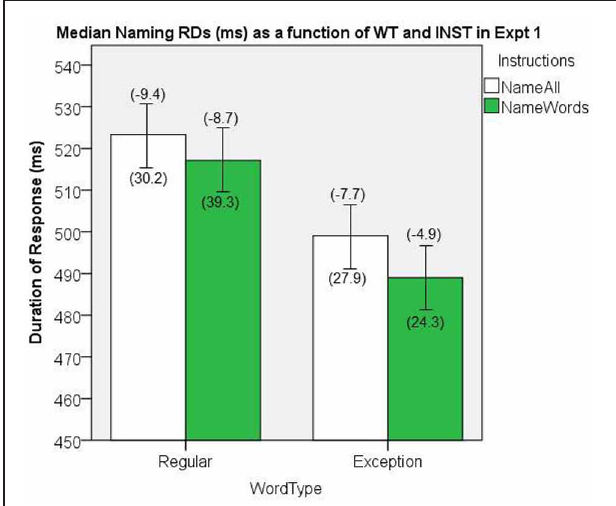
FIGURE 7 | Median Naming RDs (in ms) as a function of WT and INST in Experiment 1. The 95% C.I.s are presented as error bars using Loftus and Masson’s (1994) method. Co-efficients relating WF to RT